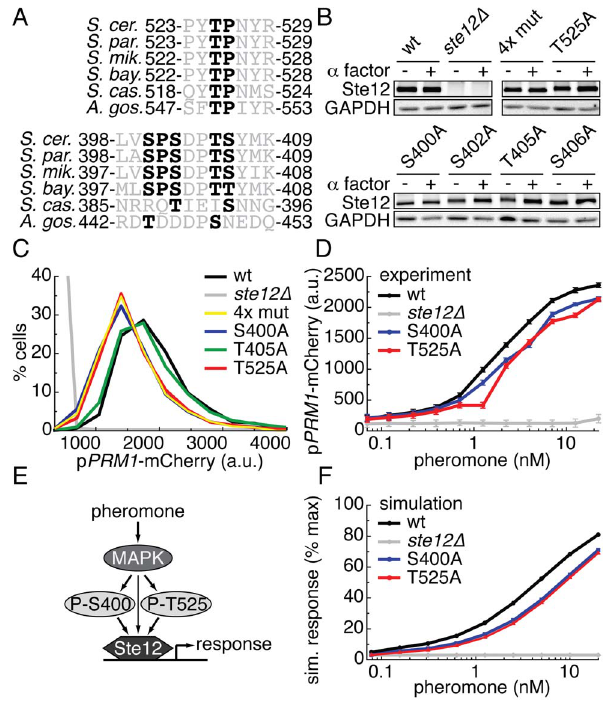
Figure 2. Two phosphorylation sites in Ste12 are required for full transcriptional induction. A. Alignment of 2 tryptic phospho- peptides across 6 yeast species. Possible phosphorylation sites (serines and threonines) and minimal MAPK consensus sequences (S/T,P) are in bold. B. Western blots of lysate from yeast strains containing the indicated wild type or mutant Ste12, treated or not treated with 1 m M alpha factor for 15 minutes probed with anti-Ste12 and anti-GAPDH. 4x mut is Ste12 S400A,S402A,T405A,S406A . C. Histograms of the single cell (n . 2000 cells) pheromone response measured by p PRM1 -mCherry fluorescence. Cells were treated with 4 nM alpha factor for 3 hrs followed by cycloheximide for 2 hrs, and measured by flow cytometry. D. Dose responses of cells treated with 12 concentrations of pheromone as described in C. Figure plots means of the unimodal distributions. Error bars depict the standard error of the mean. E. Cartoon model of the function of the phosphorylation of S400 and T525 F. Simulation of the ODE model across a dose response of